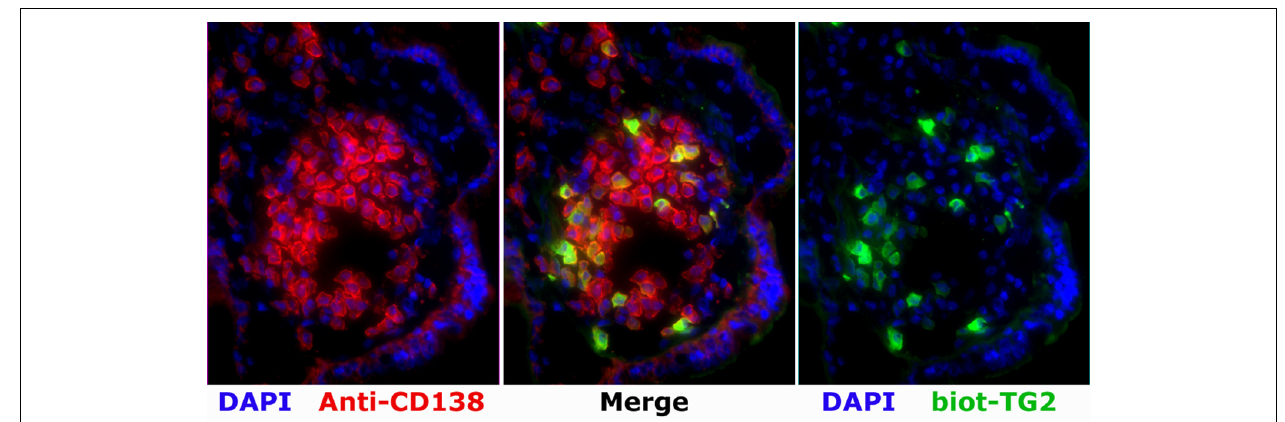
FIGURE 1 |A patch with high frequency ofTG2-specific PCs as revealed by immunofluorescence analysis on a cryosection of the duodenal mucosa of a patient with active CD. Staining performed with biotinylatedTG2 (biot-TG2, followed by fluorescent streptavidin, green ), a plasma cell marker (anti-CD138, red ), and a nuclei stain (DAPI, blue